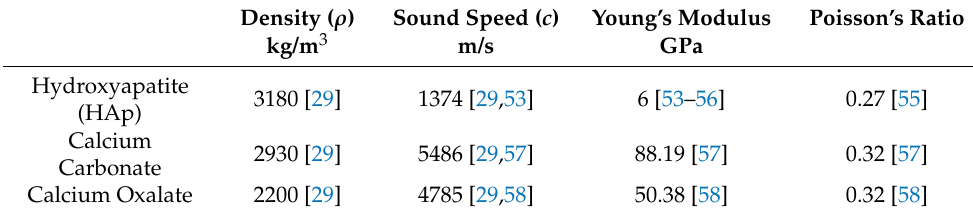
Table 2. Material properties of the microcalcification